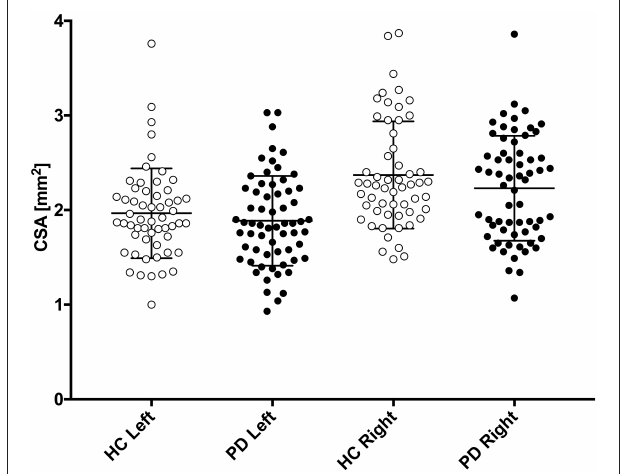
FIGURE 2 | Left and right vagus nerve cross-sectional area (CSA) is presented for patients with Parkinson’s disease (PD, black circles) and healthy controls (HC, white circles). Mean and standard deviation is depicted with black error